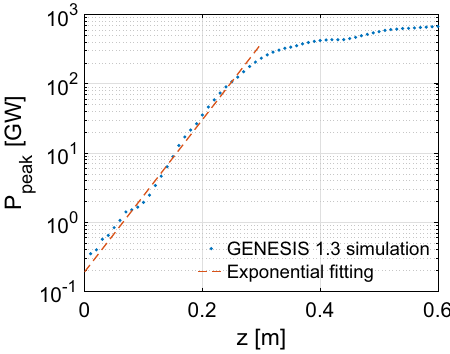
Fig. 4 Simulation results of X-ray generation. The peak power of the radiation along the undulator from GENESIS simulation (blue dots) and the exponential fi tting (red line).